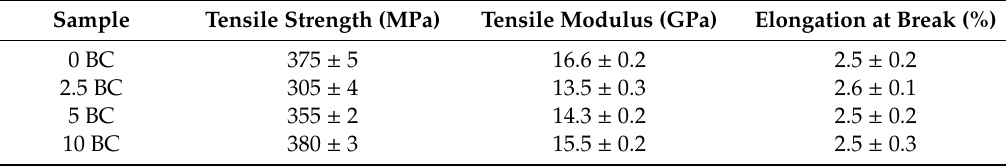
Table 3. Tensile test values of the tested materials.